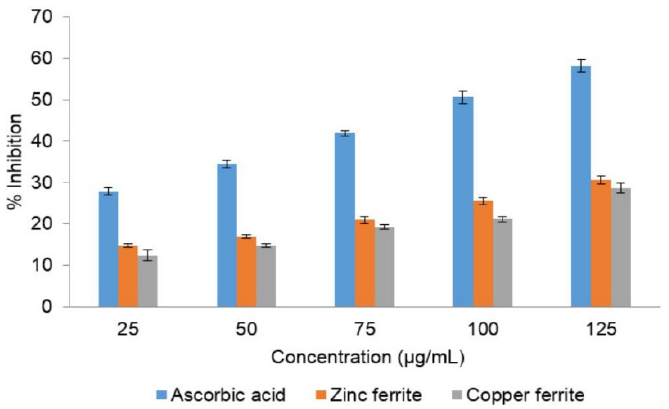
Figure 5. 2,2 ‐ diphenyl ‐ 1 ‐ picrylhydrazyl hydrate (DPPH) free radical scavenging activities of ascorbic acid, CuFe 2 O 4 and ZnFe 2 O 4 nanoparticles. Each value is expressed as a mean of ± Standard Deviation (S.D, n =